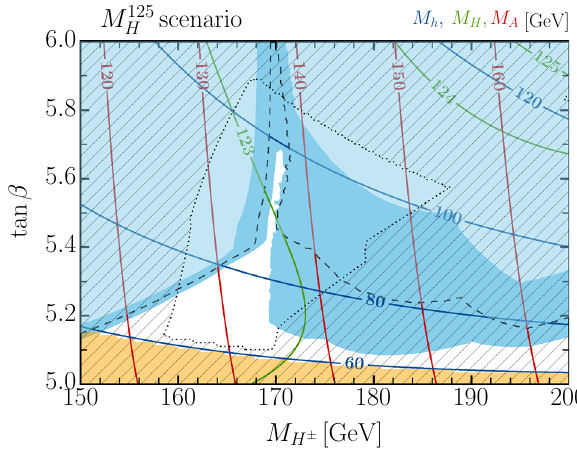
Fig. 10 Constraints on the M 125 scenario from Higgs searches at the H LHC, in the ( M H ± , tan β) plane. The blue, green and red solid lines are predictions for the masses of h , H and A , respectively. The hatched area is excluded by a mismatch between the properties of H and those of the observed Higgs boson, and the areas bounded by dashed lines are excluded by the searches for additional Higgs bosons (the darker-blue band shows the theoretical uncertainty of the exclusion). At low tan β , the orange area is excluded by searches for H →